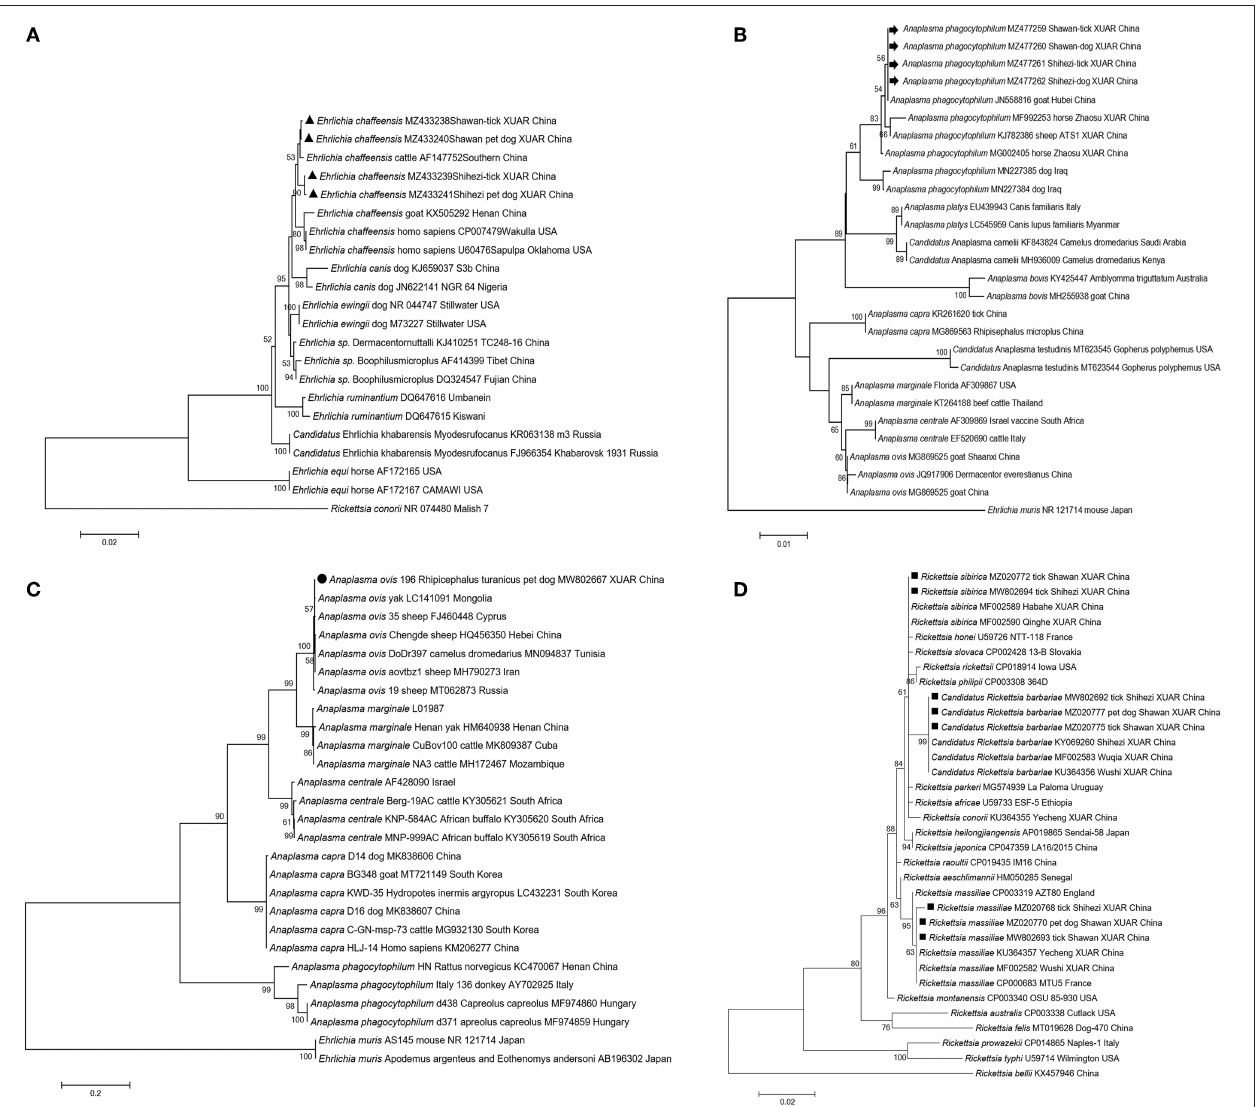
Frontiers in Veterinary Science |